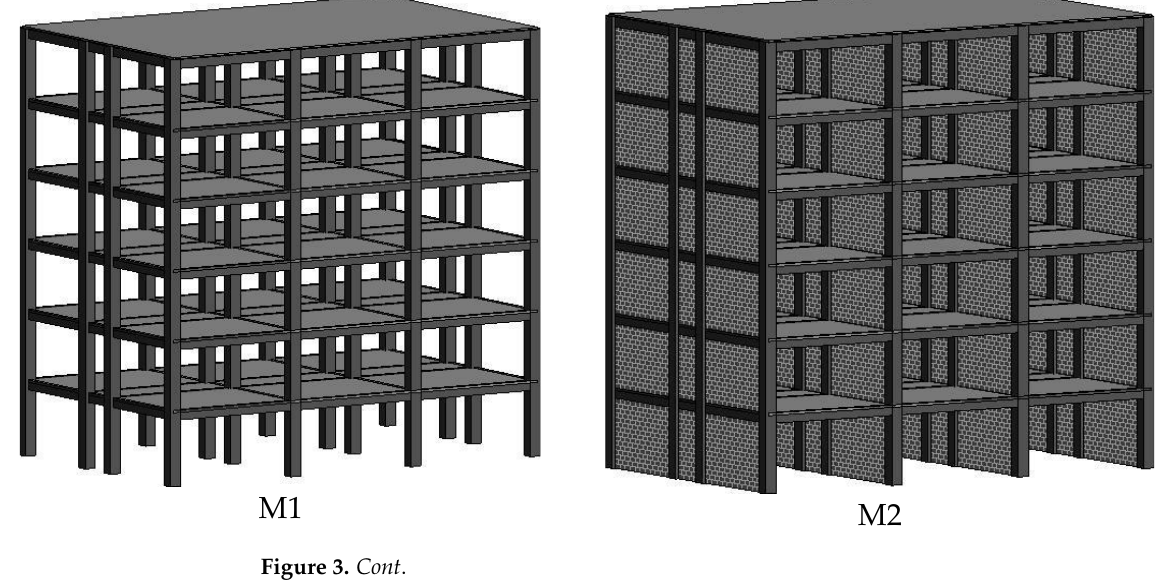
Table 3. The mechanical properties of reinforcements and concrete.